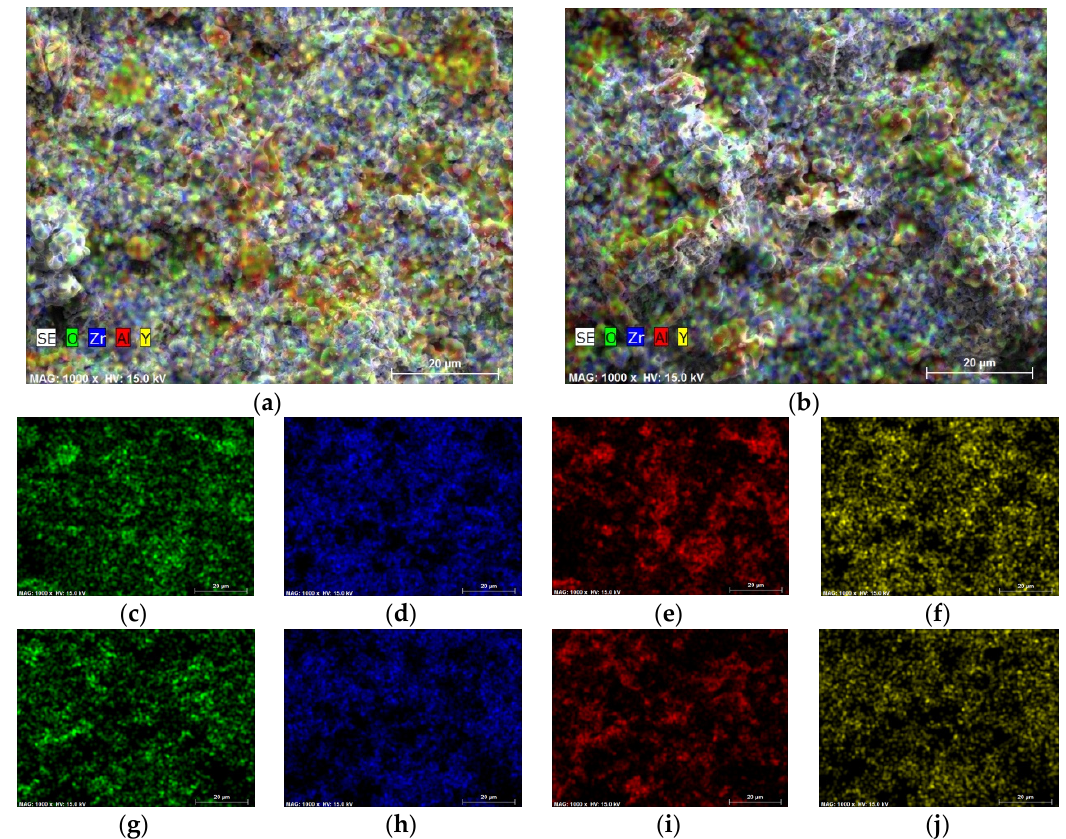
Figure 2. Surface micrographs and elemental maps of Al 2 O 3 -ZrO 2 coatings deposited at ( a , c – f ) 180 A and ( b , g – j ) 220 A, ( c , g ) oxygen, ( d , h ) zirconium, ( e , i ) aluminum and ( f , j ) yttrium.